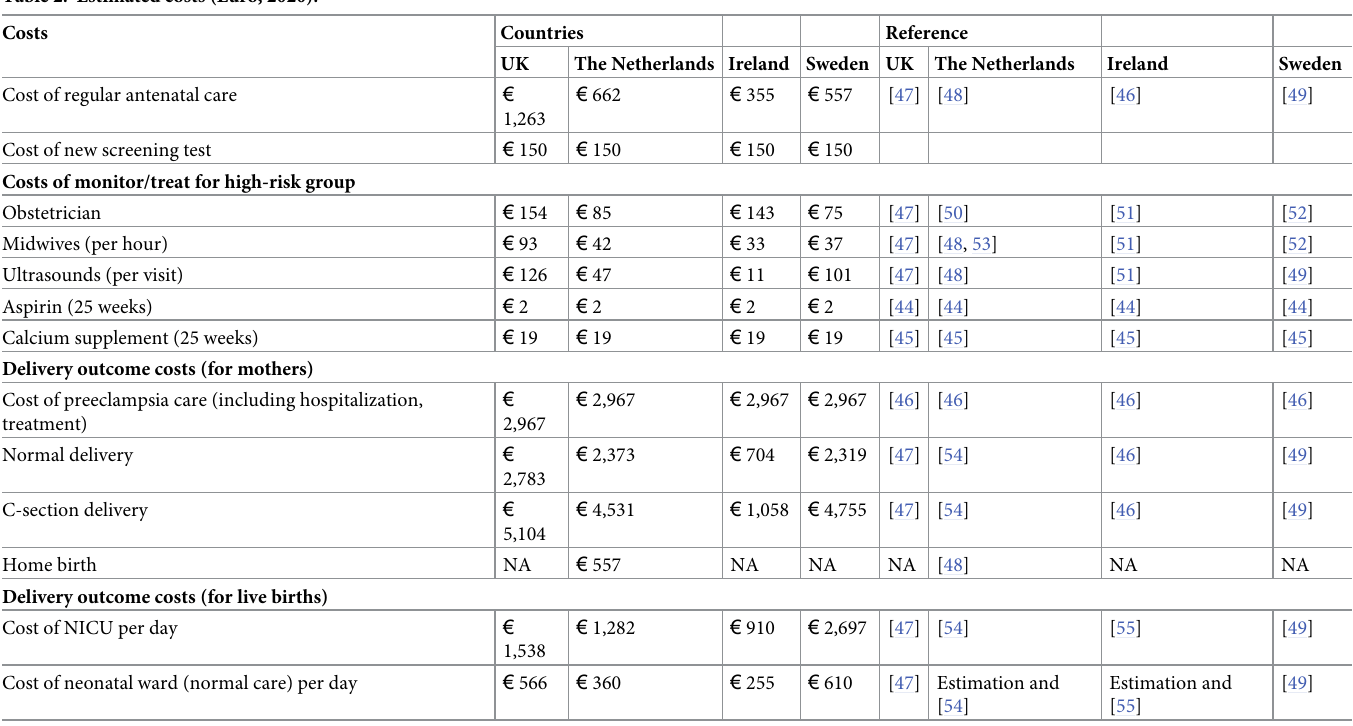
Table 2. Estimated costs (Euro,